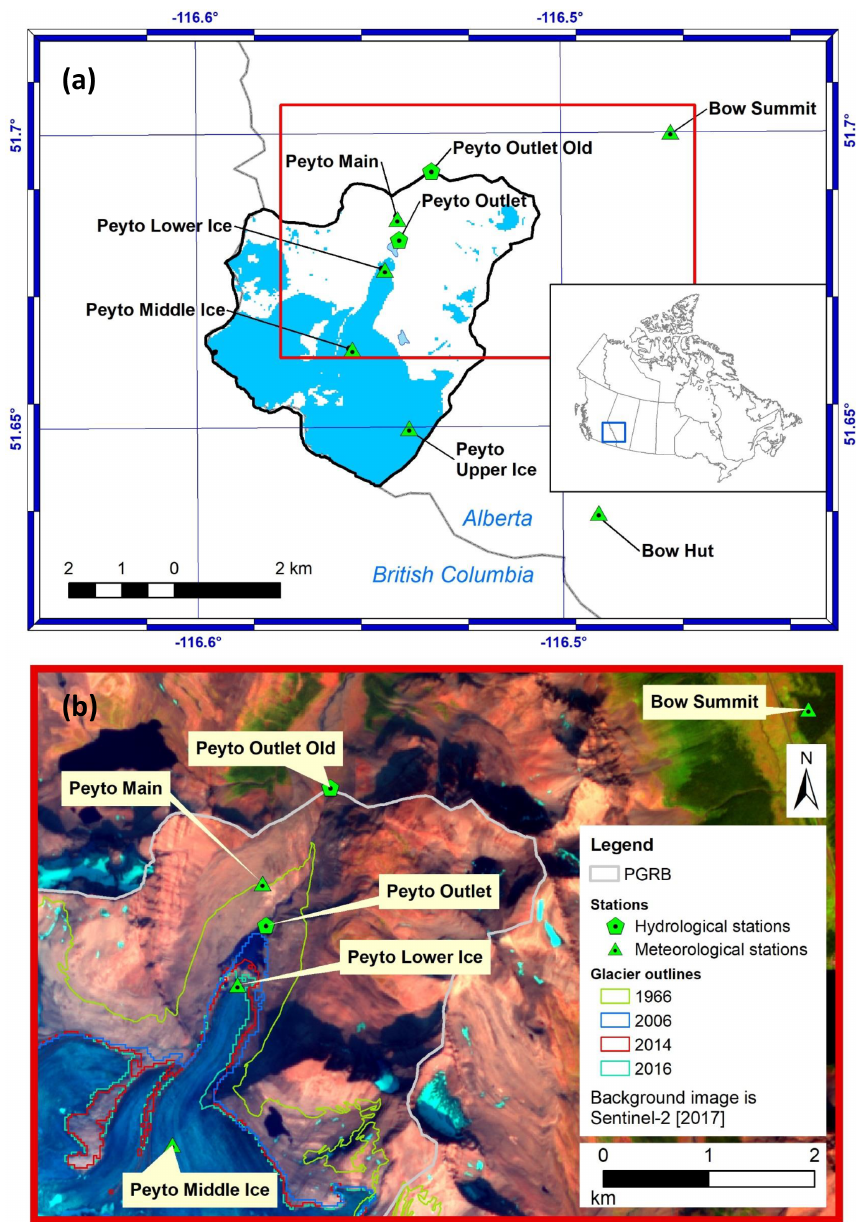
Figure 1. Peyto Glacier Research Basin (PGRB). (a) Locations of PGRB and the hydrometeorological stations; blue areas are glacier within PGRB. (b) Past and present glacier